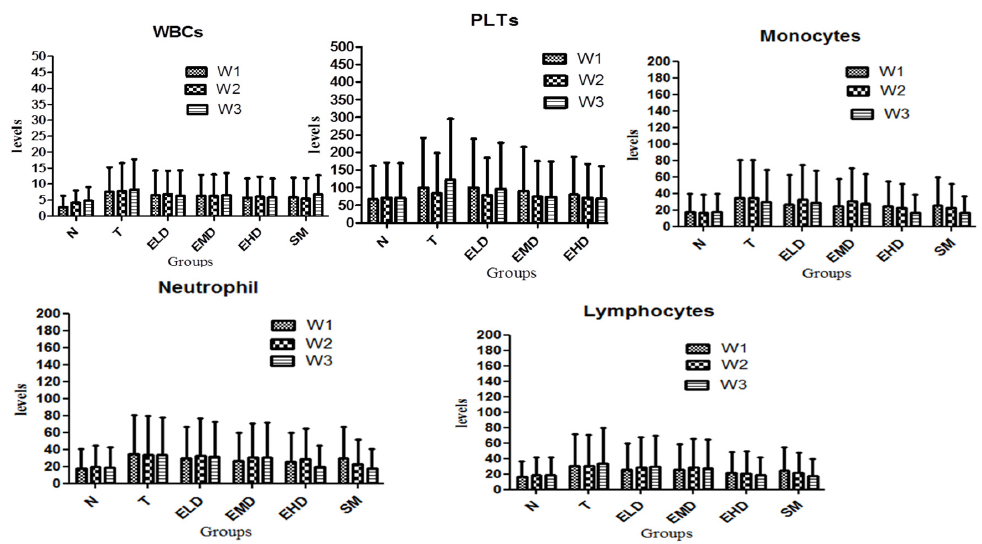
Figure 1. Graphical representation of hematological indices at week 1, week 2 and week 3 of differ ‐ ent experimental groups (Table 1).